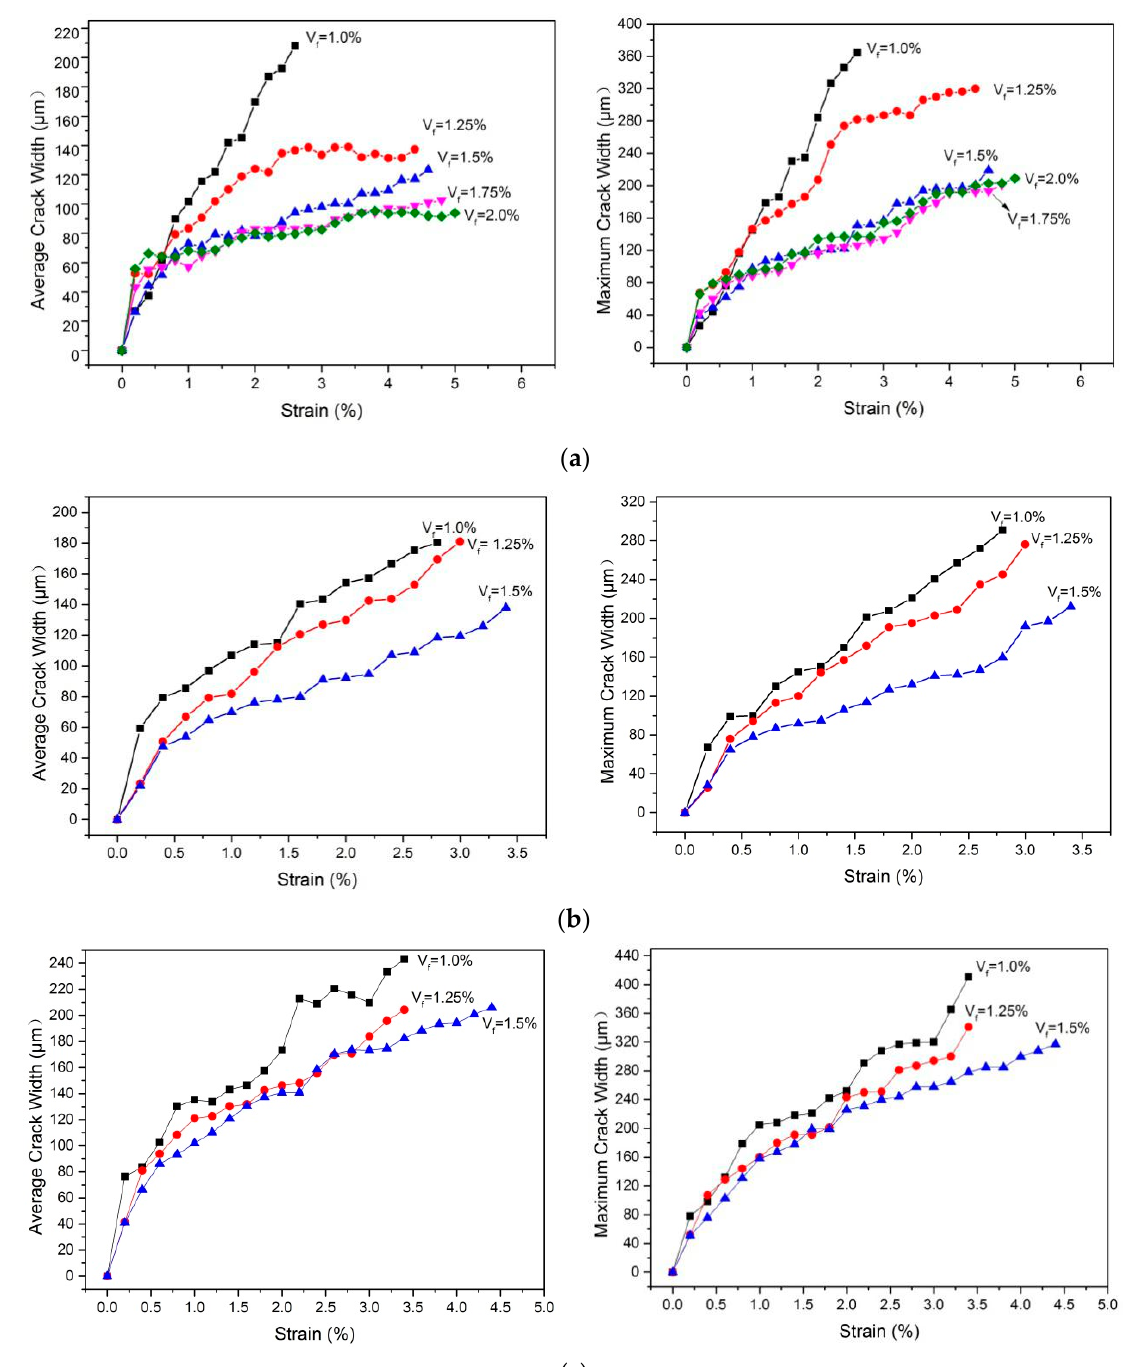
Figure 17. Crack development of GLECC mixtures containing different FAC content. ( a ) GLECCs with FAC content of 0.15; ( b ) GLECCs with FAC content of 0.3; ( c ) GLECCs with FAC content of 0.45.